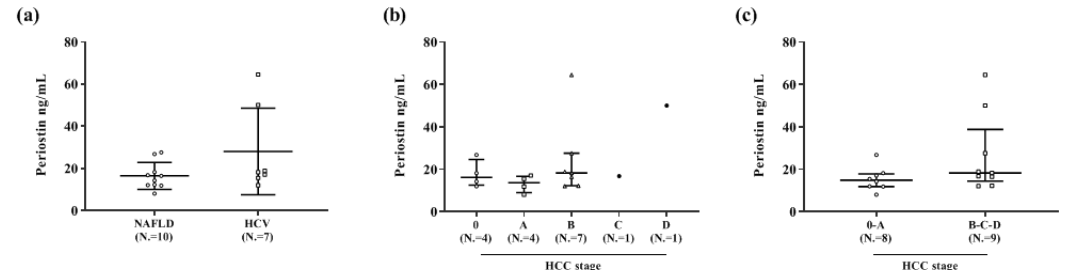
Figure 2. Scatterplot of the distribution of plasma periostin values in HCC patients. NAFLD: non- alcoholic fatty liver disease; HCV: hepatitis C virus. ( a ): periostin concentrations according to HCC etiology. ( b ): periostin concentrations according to HCC stages. ( c ): periostin concentrations according to combined (0–A and B–C–D) HCC stages.